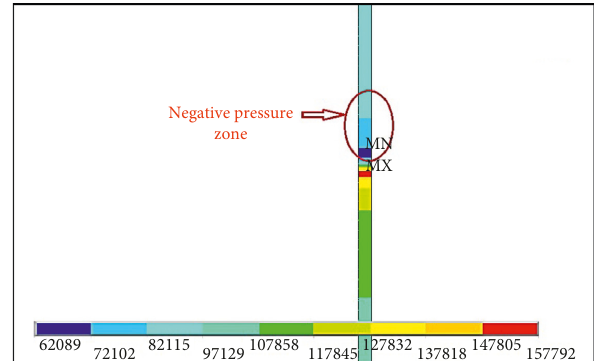
Figure 12: Nephogram of pressure at the maximum falling speed.